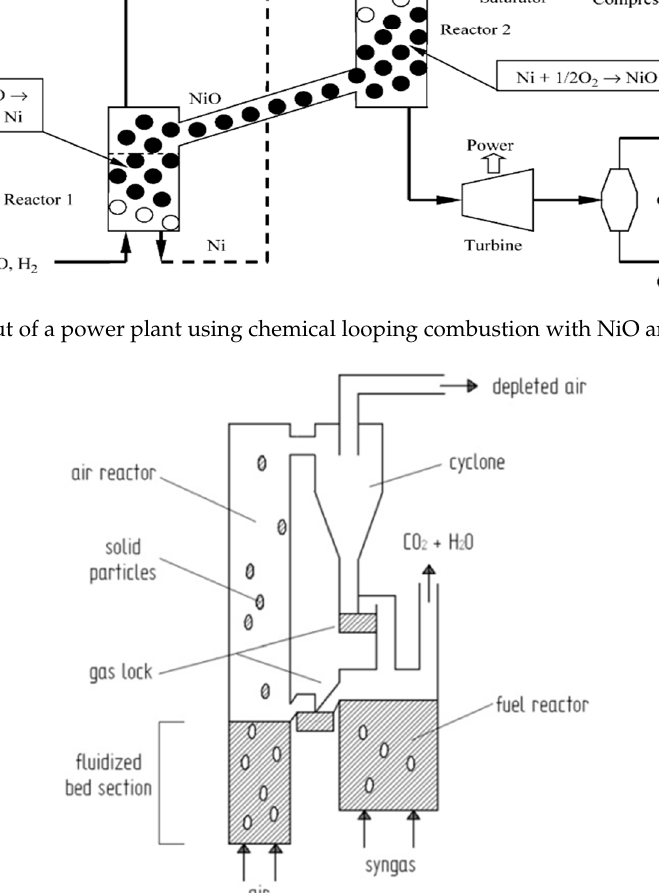
Figure 19. A CLC reactor with two interconnected fluidized beds [126].